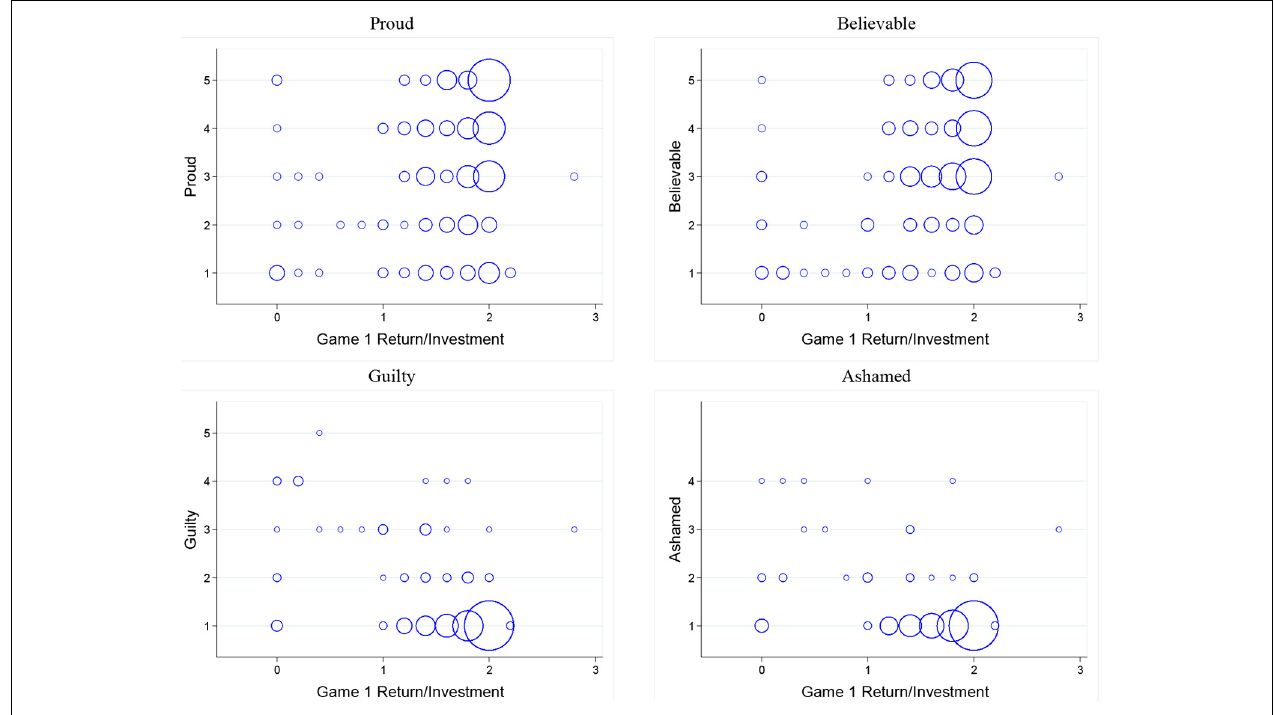
FIGURE 3 | Bubble plots of trustees’ emotions and ROI .